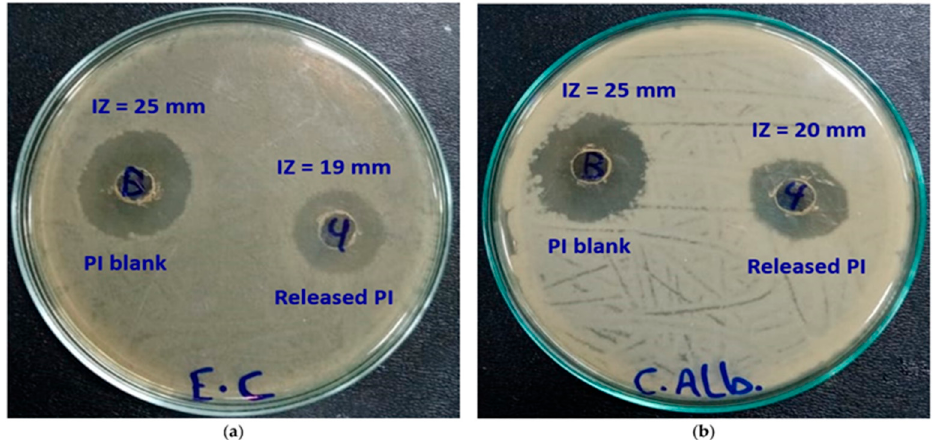
Figure 6. Antimicrobial activity of pure PI (left) and released PI (right) against ( a ) Escherichia coli ( b ) Candida albicans . Reproduced from the article [83], with permission from MDPI, 2023. PI: Polyvinylpyrrolidone (povidine)-bound iodine.